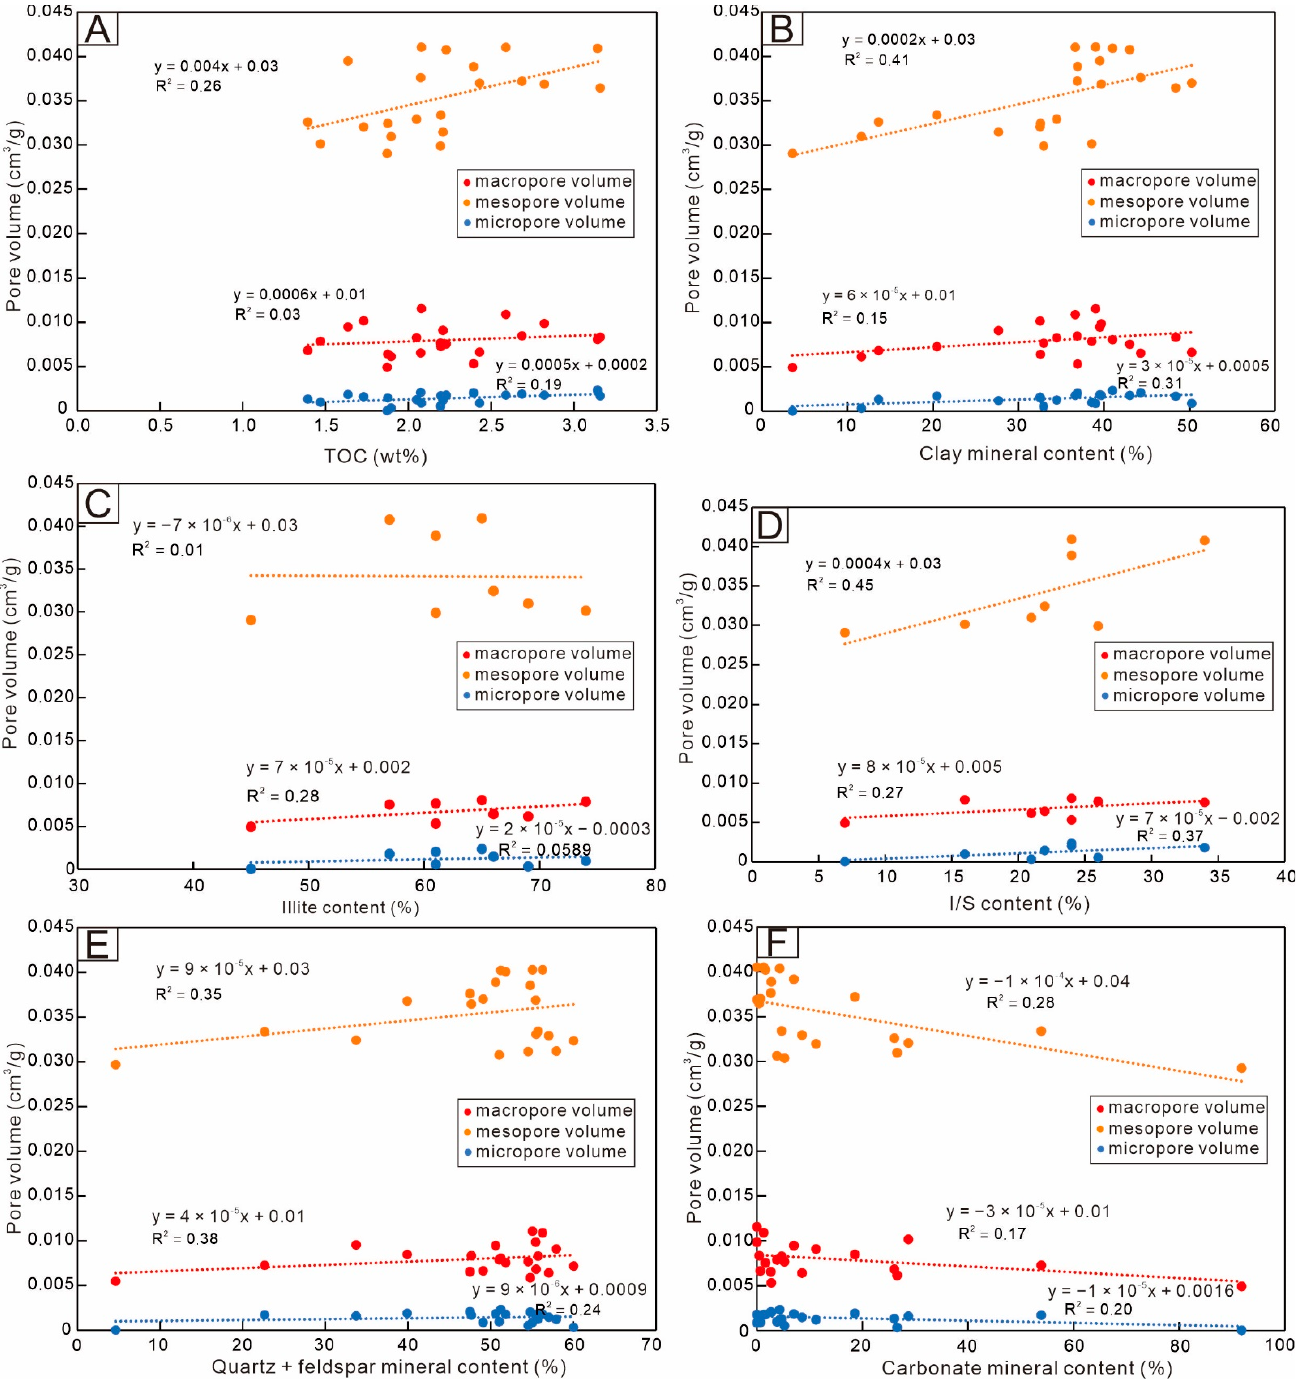
Figure 20. Cross plots showing the correlation between pore volume and TOC as well as mineral content. ( A ) The relationship between TOC and pore volume; ( B ) The relationship between clay mineral content and pore volume; ( C ) The relationship between illite content and pore volume; ( D ) The relationship between I/S content and pore volume; ( E ) The relationship between quartz + feldspar mineral content and pore volume; ( F ) The relationship between carbonate mineral content and pore volume.